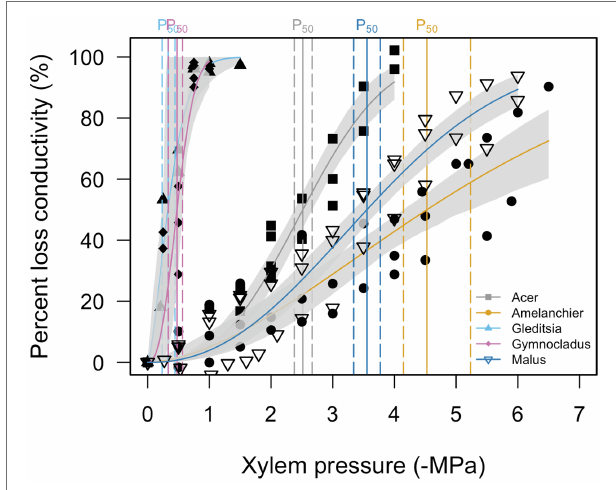
FIGURE 2 | Stem vulnerability curves for five cultivars. Gray shading around each curve shows the 95% confidence interval of the curve ( n = 3). Stem P 50 for each species is indicated by a solid vertical line and 95% confidence intervals are indicated by a dashed vertical line. Quercus is not included (see text for details).